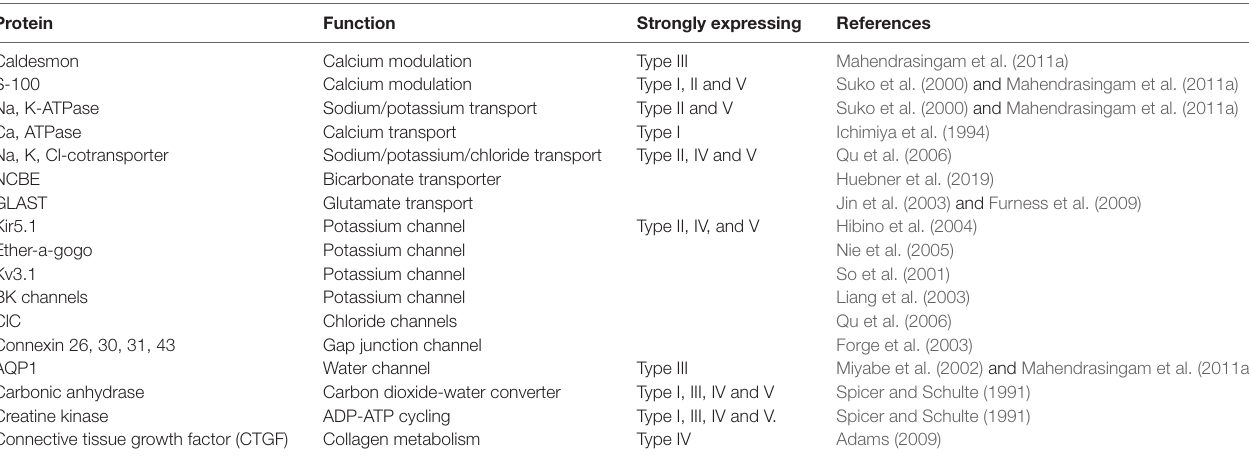
TABLE 1 | Characteristic proteins of fibrocytes.